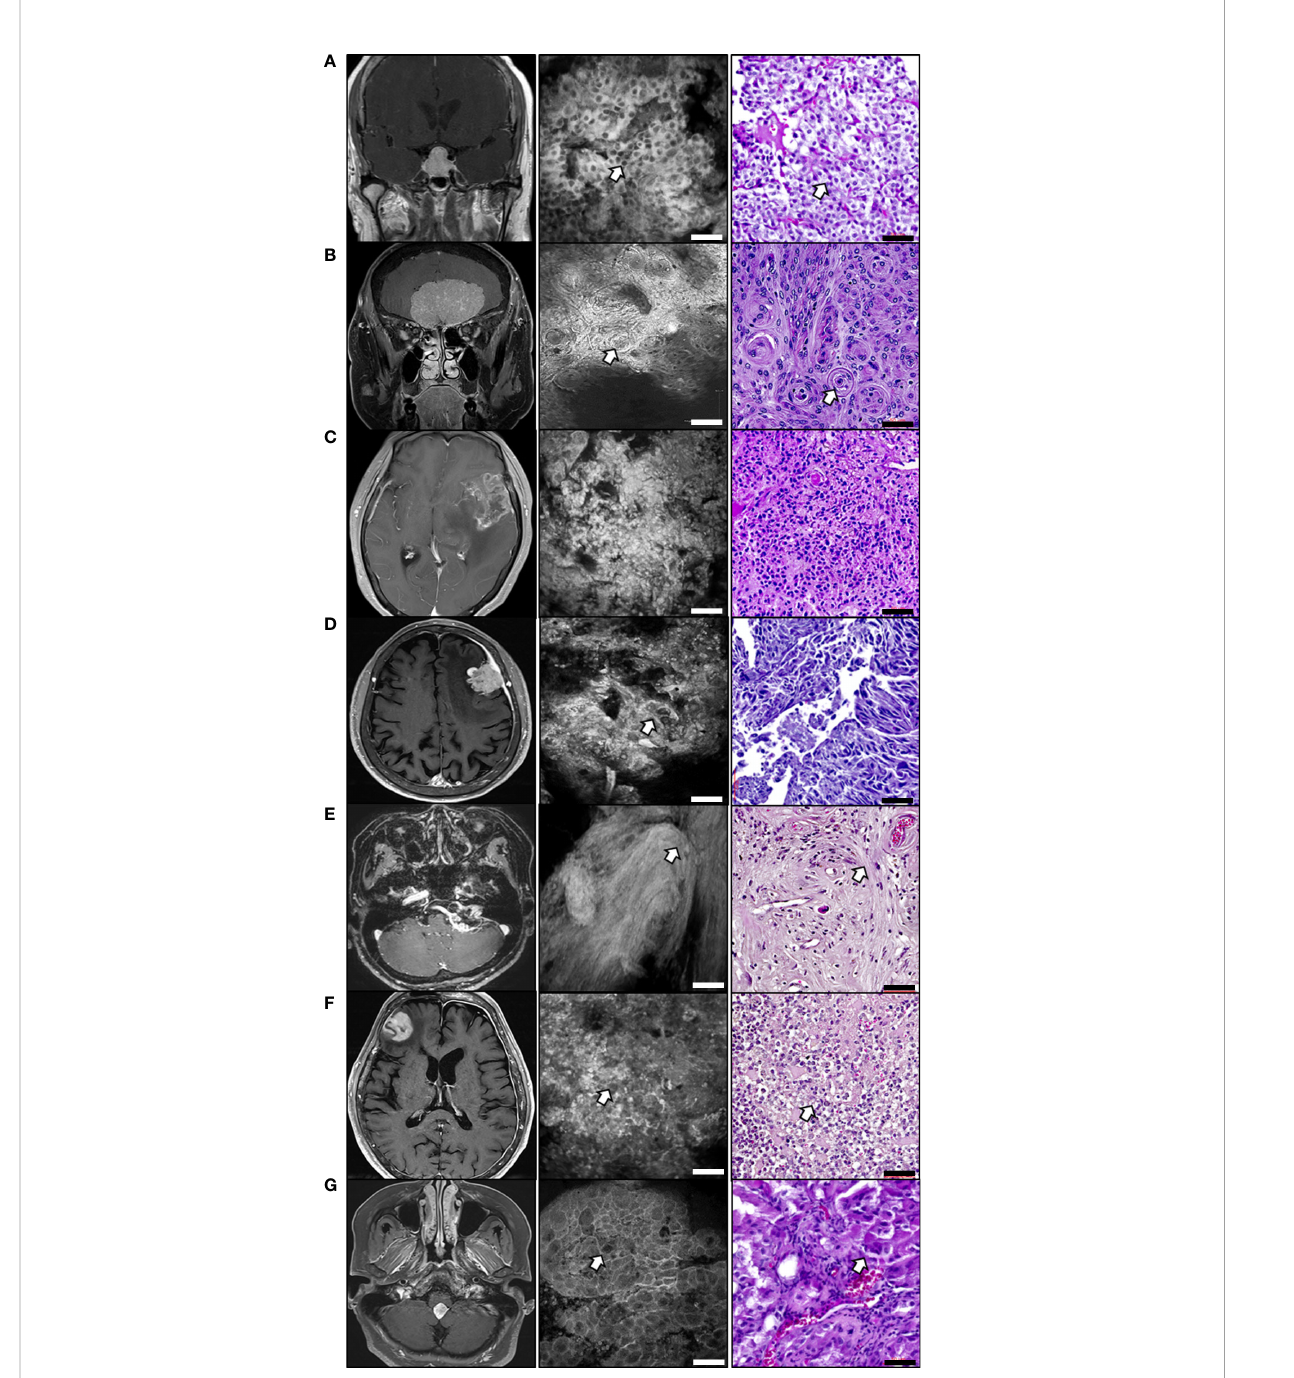
FIGURE 5 Ex vivo CLE images compared to histology in various brain tumor tissues Corresponding representative images of brain tumors consist of T1 enhanced magnetic resonance images (left), CLE images (middle), and H&E staining (right). (A) Pituitary adenoma. White arrows indicate the salt-and-pepper patterns. (B) Olfactory groove meningioma. White arrows indicate a sheet or lobular architecture that contains a whorl pattern. (C) Glioblastoma image showing the overall hypercellularity and atypia. (D) Metastatic adenocarcinoma. White arrows indicate atypical cell nests. (E) Vestibular schwannoma. White arrows indicate the spiral pattern of whorl formation. (F) Primary central nervous system lymphoma. White arrows indicate the large, atypical lymphocytes. (G) Choroidal plexus papilloma. White arrows indicate papillary structures lined with uniform cuboidal or columnar epithelial cells. Scale bar: 50 µm. H&E, hematoxylin and